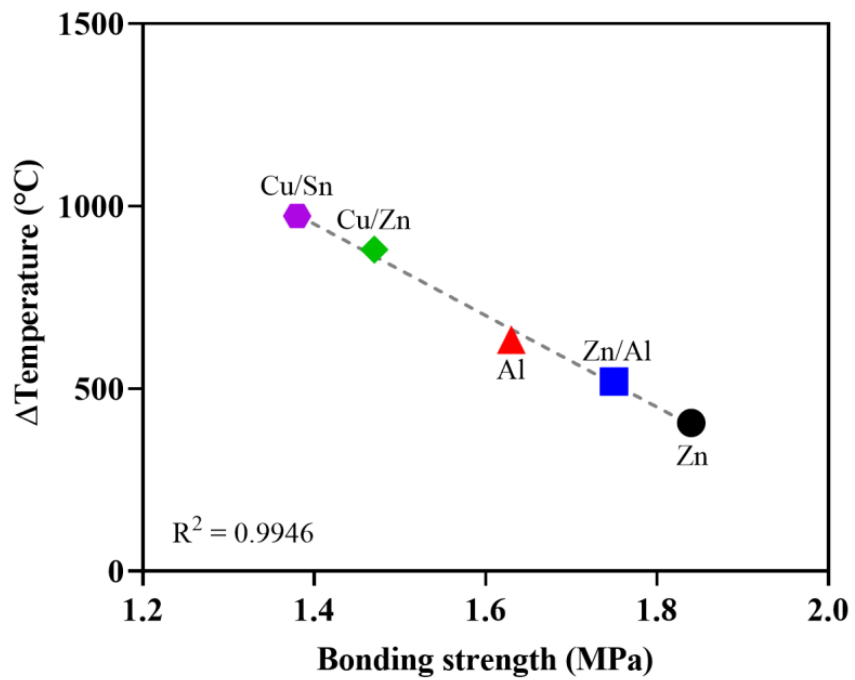
Figure 11. Relationship between the bonding strength and surface temperature.